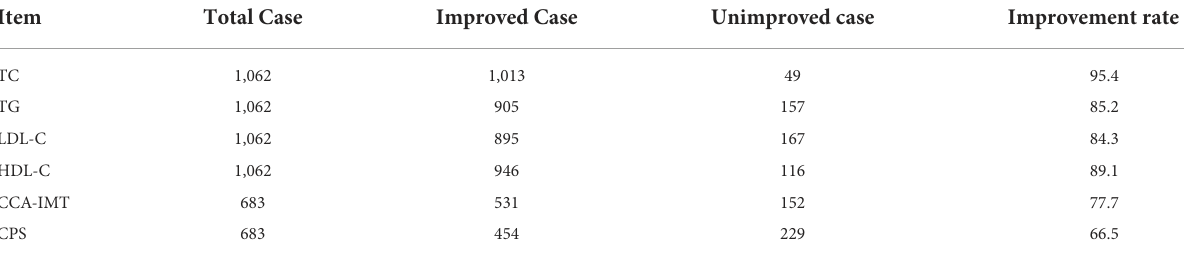
TABLE 3 Overall improvement rates following 12 months NK consumption (10,800 FU daily).